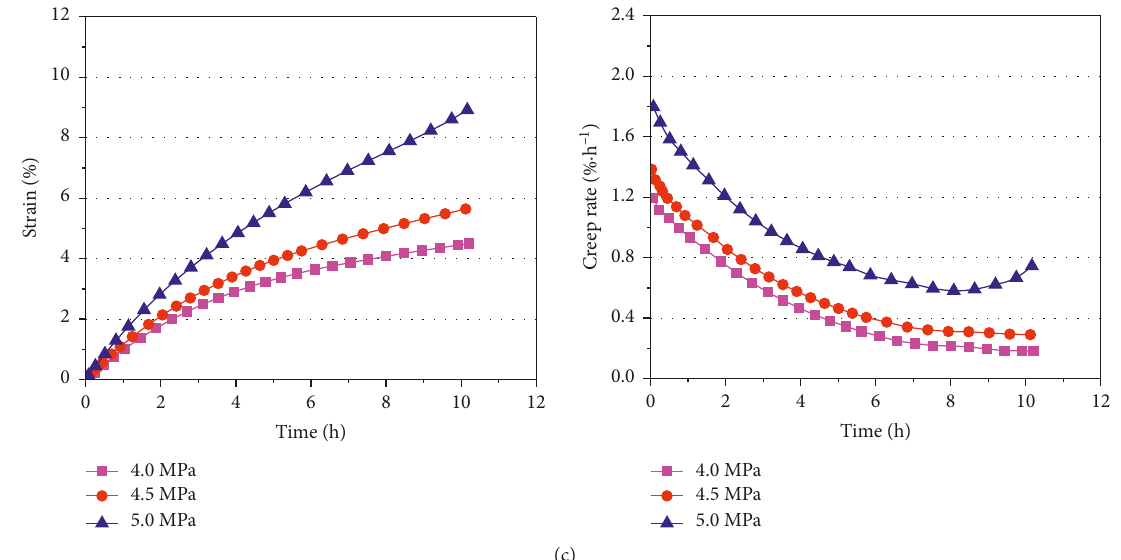
Figure 3: Variations in axial creep strain and axial creep rate with time ( σ